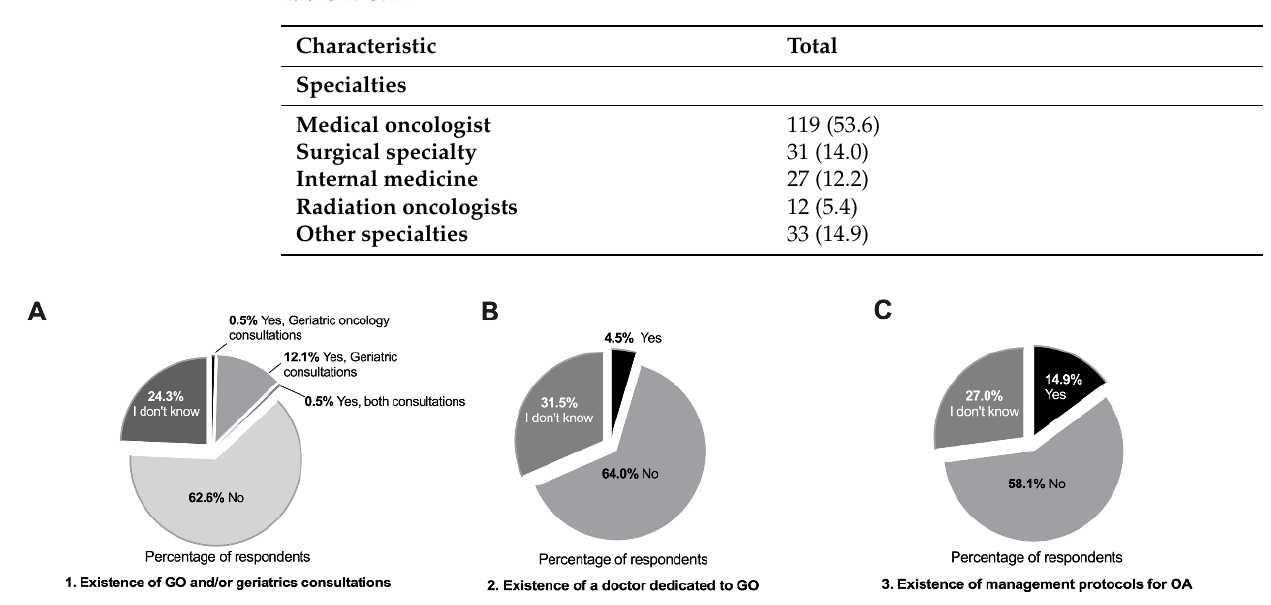
Figure 1. Geriatric oncology situation in Portuguese hospitals. ( A ) Frequency of geriatric oncology and/or geriatrics care in Portuguese hospitals. ( B ) Medical oncology departments with physicians practicing geriatric oncology. ( C ) Existence of specific management protocols for the care of elderly cancer patients. ( A – C ) Values are expressed as percentages, total number of answers (n = 222). Abbreviations: GO—geriatric oncology; OA—older adults.